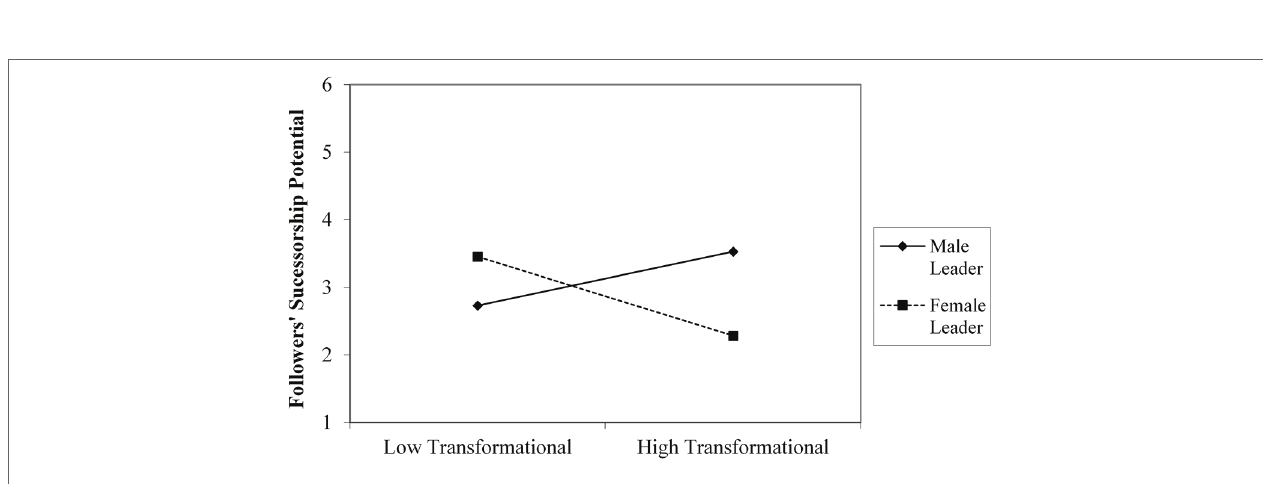
FIGURE 3 | Interactive relationship of followers’ evaluation of leaders use of a transformational style and leader gender with leaders’ assessment of followers’ successorship potential (study 1).